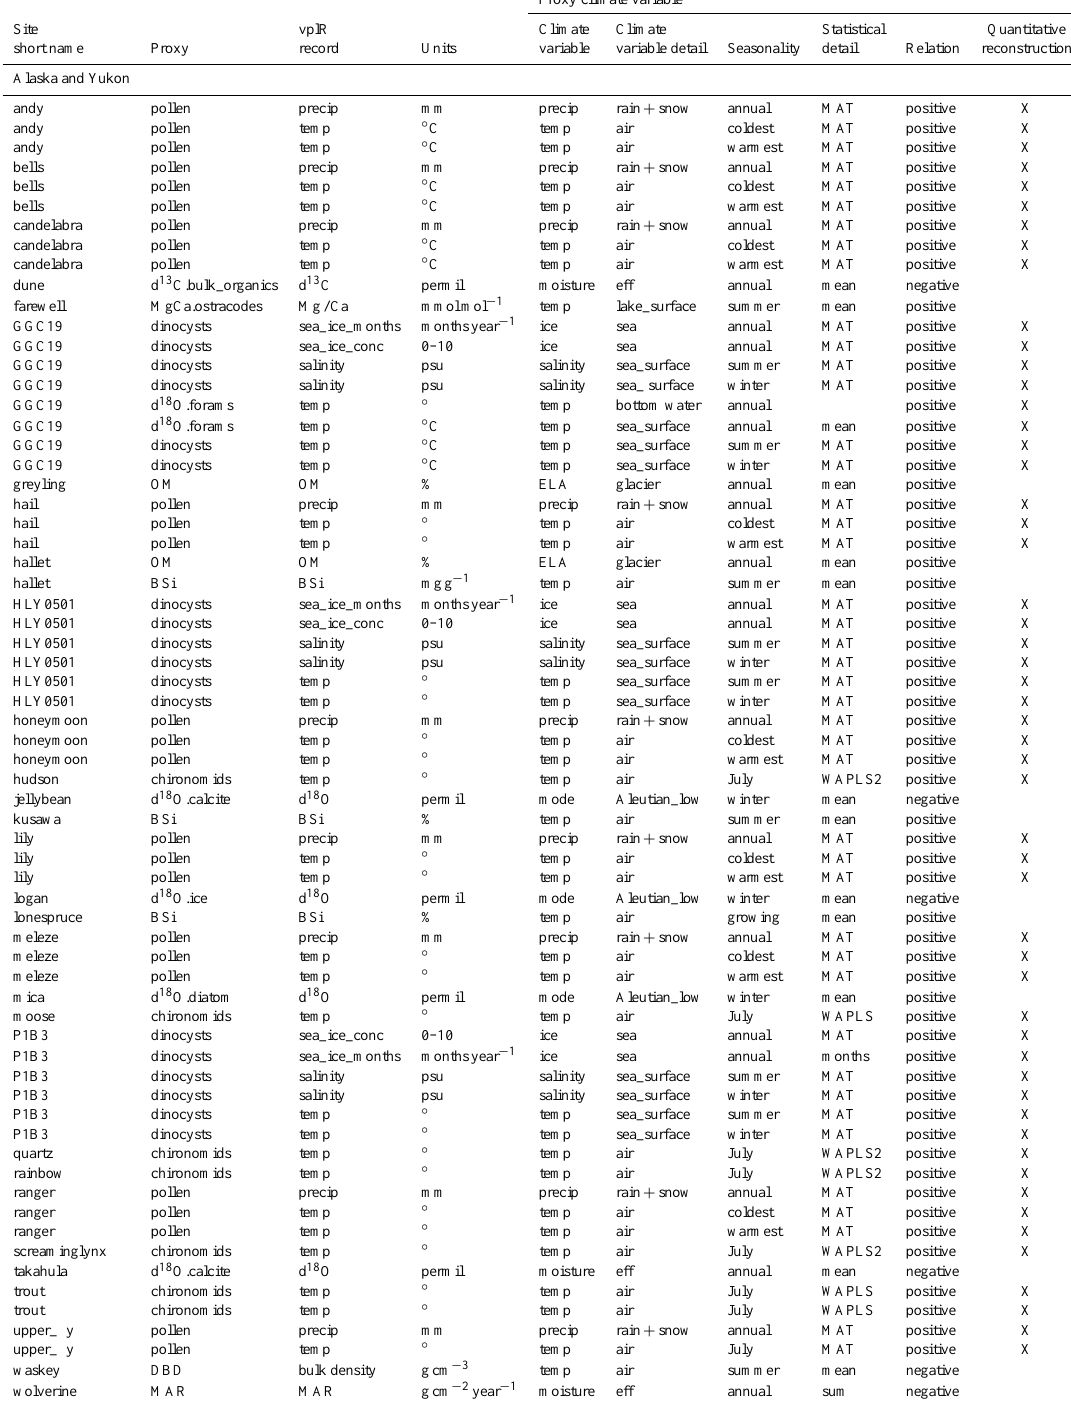
Table 2. Proxy records in the database arranged by six Arctic regions. See Table 1 for information about each site. (Notes. See Table 1 for explanation of punctuation and abbreviations for proxy types; see text for discussion of “proxy climate variable”; site short name: title of tab in excel spreadsheet – database with proxy and geochronology data; vplR record: time series heading within the proxy data sheet; statistical detail abbreviations as follows: ML: maximum likelihood, MAT: modern analog technique, RESP: response surface, PLS: partial least squares, SDF: speleothem delta function, WAPLS: weighted-average partial least squares; unit abbreviations as follows: smow: standard mean ocean water, pdb: pee dee belemnite, cgs: centimeter–gram–second system, psu: practical salinity unit; climate variable explanations as follows: ELA: equilibrium-line altitude, eff: